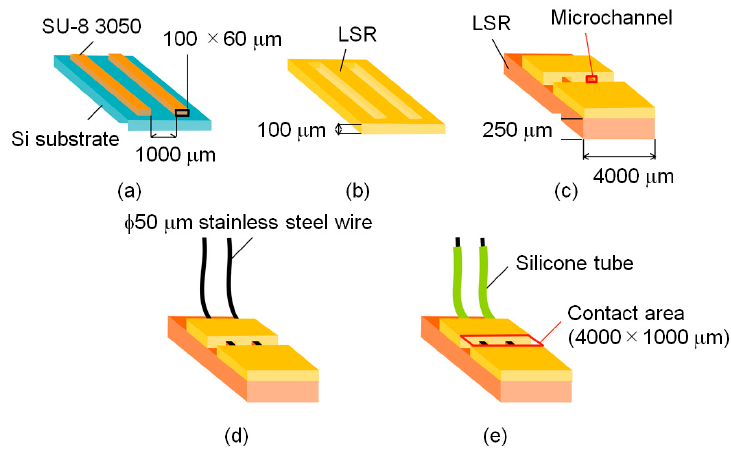
Figure 5. Fabrication procedure of the cuff electrode. The sequence from ( a – e ) indicates the sequential assembly steps of the electrode.